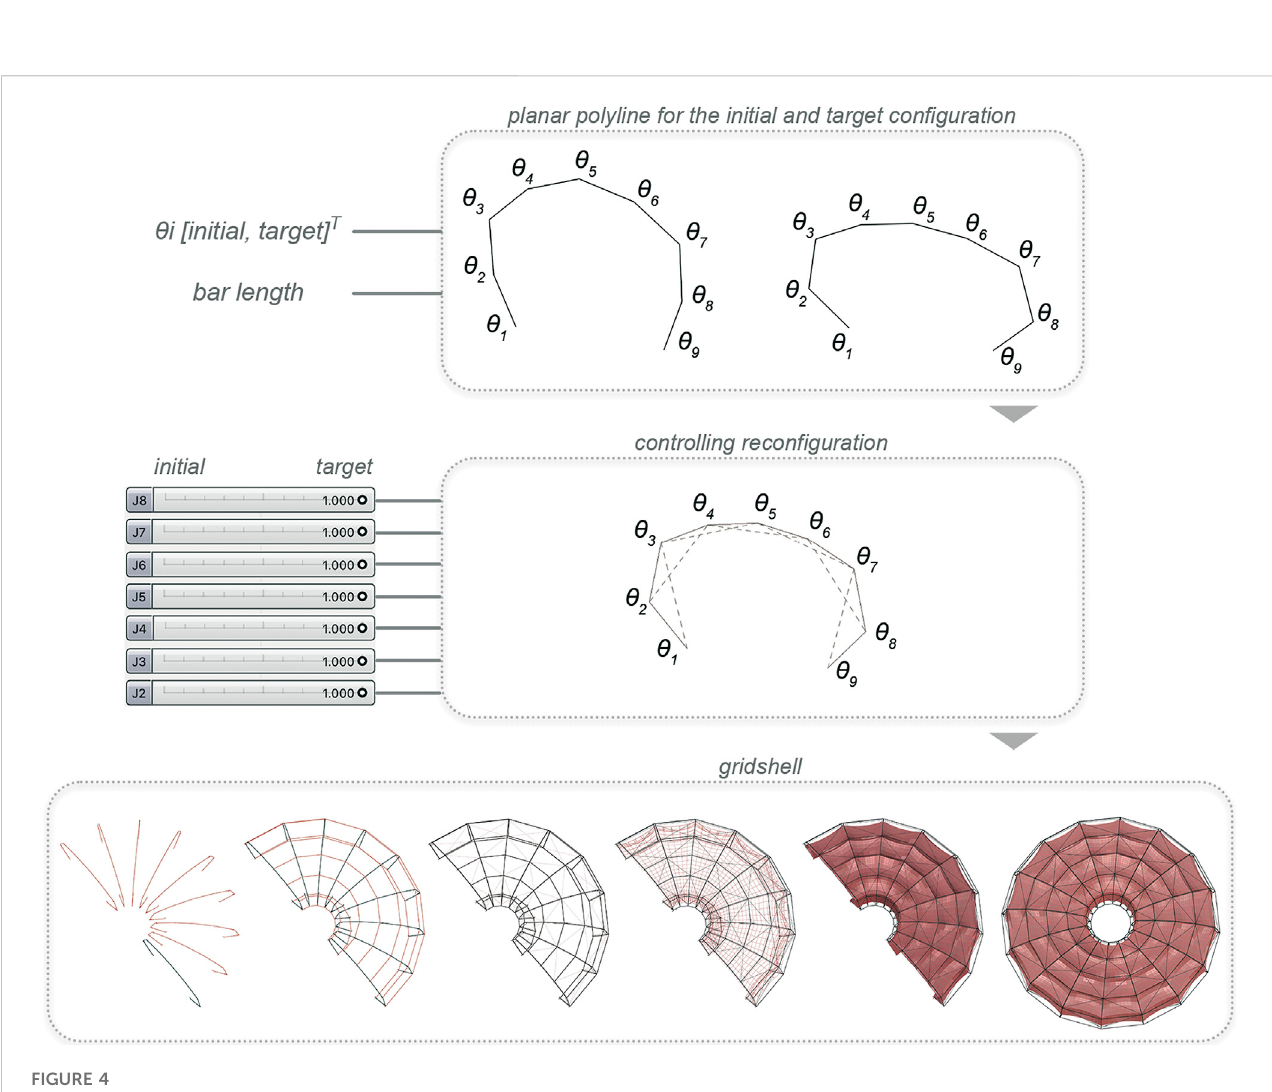
FIGURE 4 Building sections and isometric views of the transformation steps based on the E4B